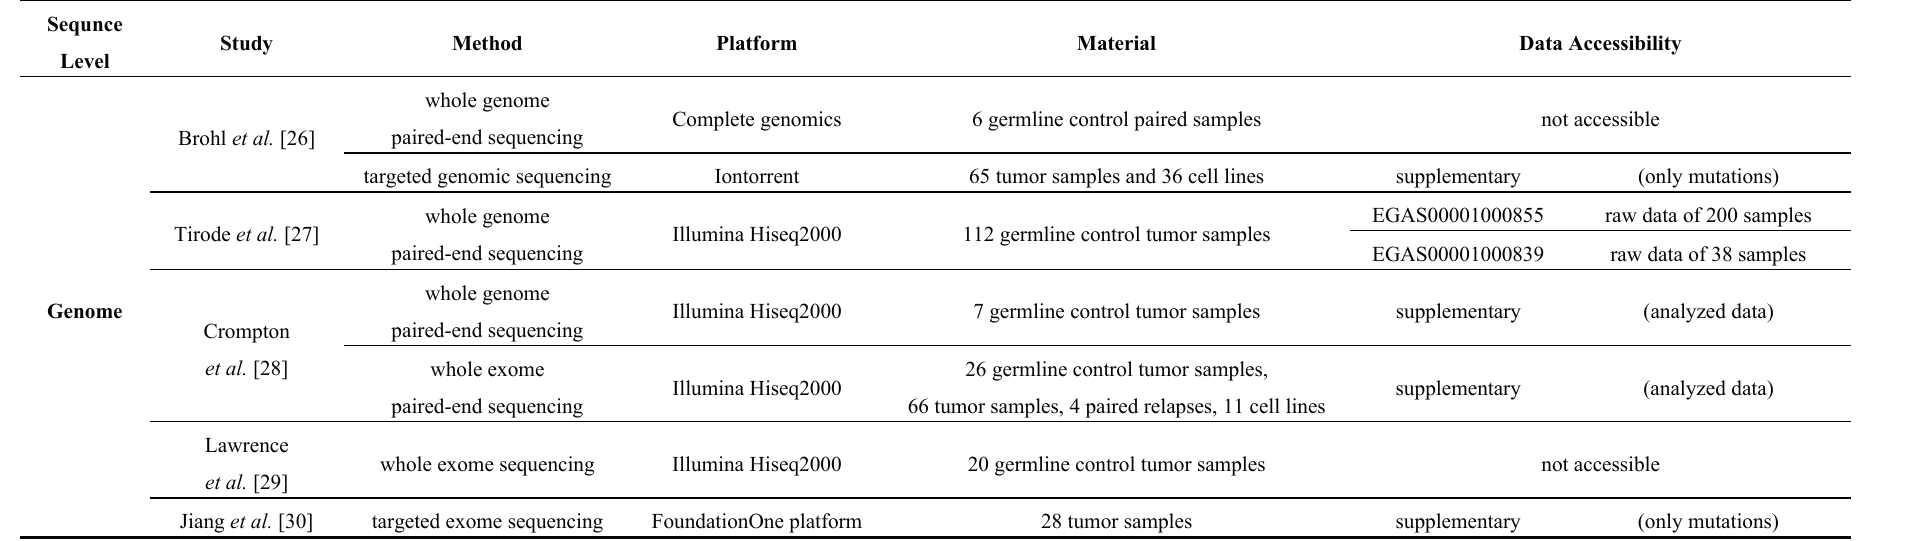
Table 1. Next generation sequencing studies in Ewing